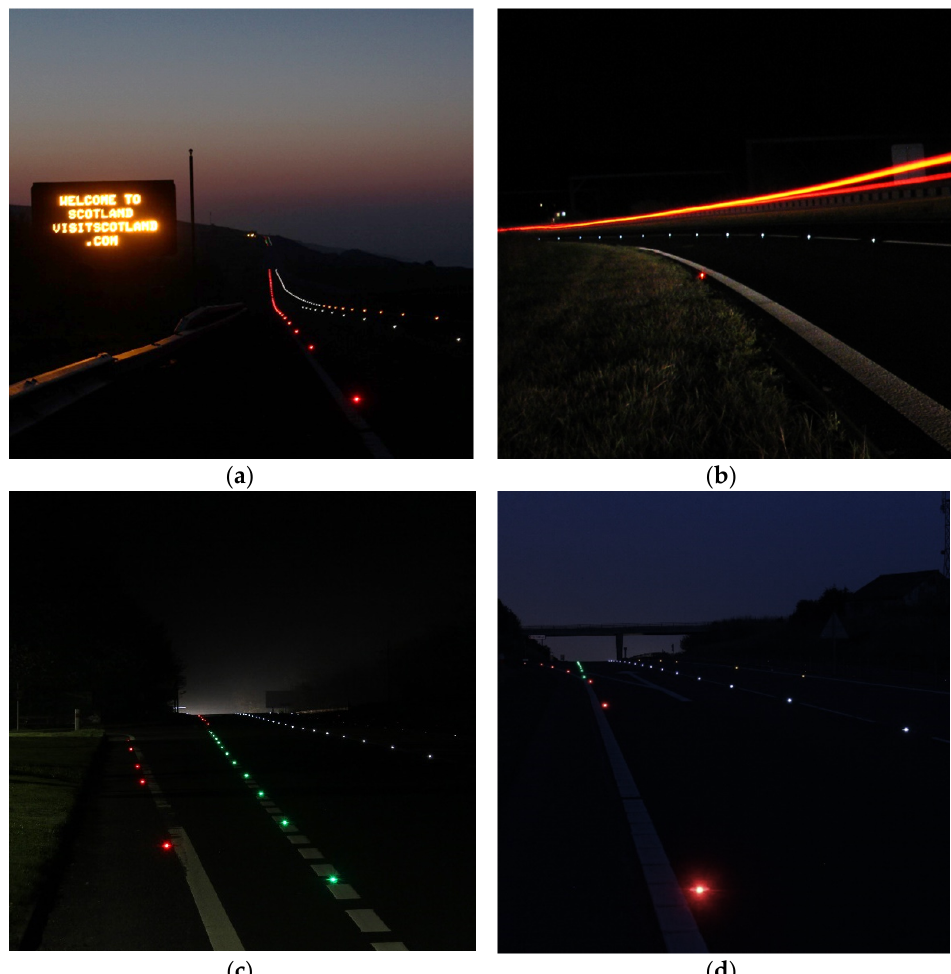
Figure 1. Example active stud installations: ( a ) dual to single carriageway merge; ( b ) single carriageway curve; ( c ) single carriageway junction; ( d ) dual carriageway junction.